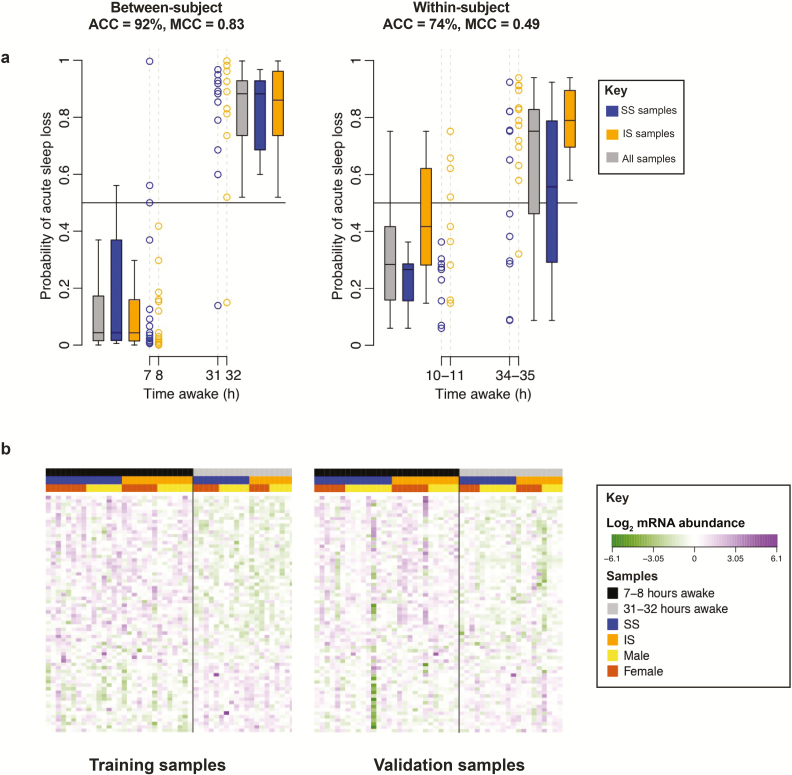
Classification performance for “acute sleep loss” between- and within-subject. (a) Classification of a sample to two classes: “acute sleep loss” and “no acute sleep loss.” “Between-subject” refers to the classification of “acute sleep loss” from a single transcriptome sample, collected at 7–8 hr or 31–32 hr of time awake. “Within-subject” refers to the classification of “acute sleep loss” from a baseline-corrected transcriptome sample collected at 10–11 hr or 34–35 hr of time awake. Black horizontal line represents the decision boundary for classifying a sample at a probability of 0.5. Blue: samples taken following 1 wk of sufficient sleep; gold: samples taken following 1 week of insufficient sleep, gray: all samples. Data shown based on the final “all features” elastic net model trained on all samples within the “UPUS” training set and applied to all samples within the corresponding independent validation set. ACC = accuracy. (b) Distribution of mRNA abundance values for features selected as classifiers of the sleep debt variable “acute sleep loss” when applying elastic net to “all features” within the “UPUS” training set (without baseline correction). mRNA abundance data is shown for all samples within the “UPUS” training and validation sets with no baseline correction.